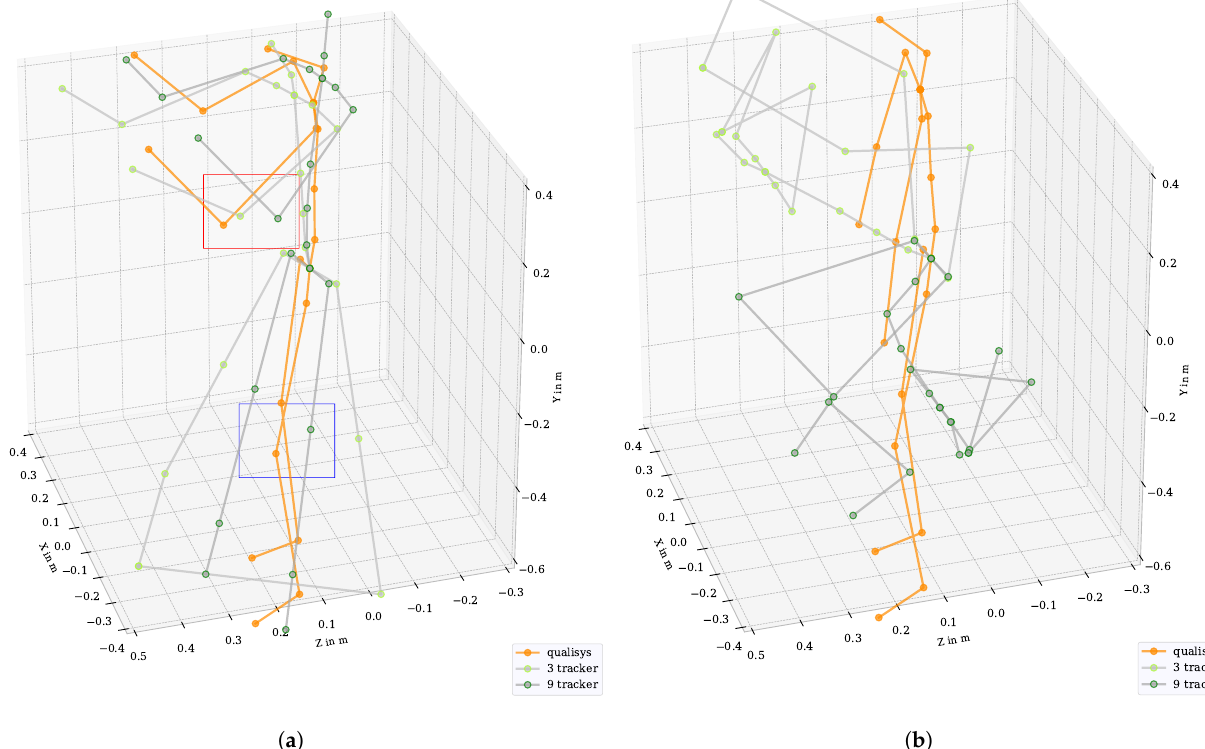
Figure 19. Tracking problems identified by comparing the kinematic data between Qualisys and Vive in tracker configura- tions 3 and 9. ( a ) Kinematic differences with a focus on the elbow between tracker and Qualisys (red box). Error based on a rigid knee in trackers (blue box). ( b ) Illustration of an implausible representation of kinematic data by tracker